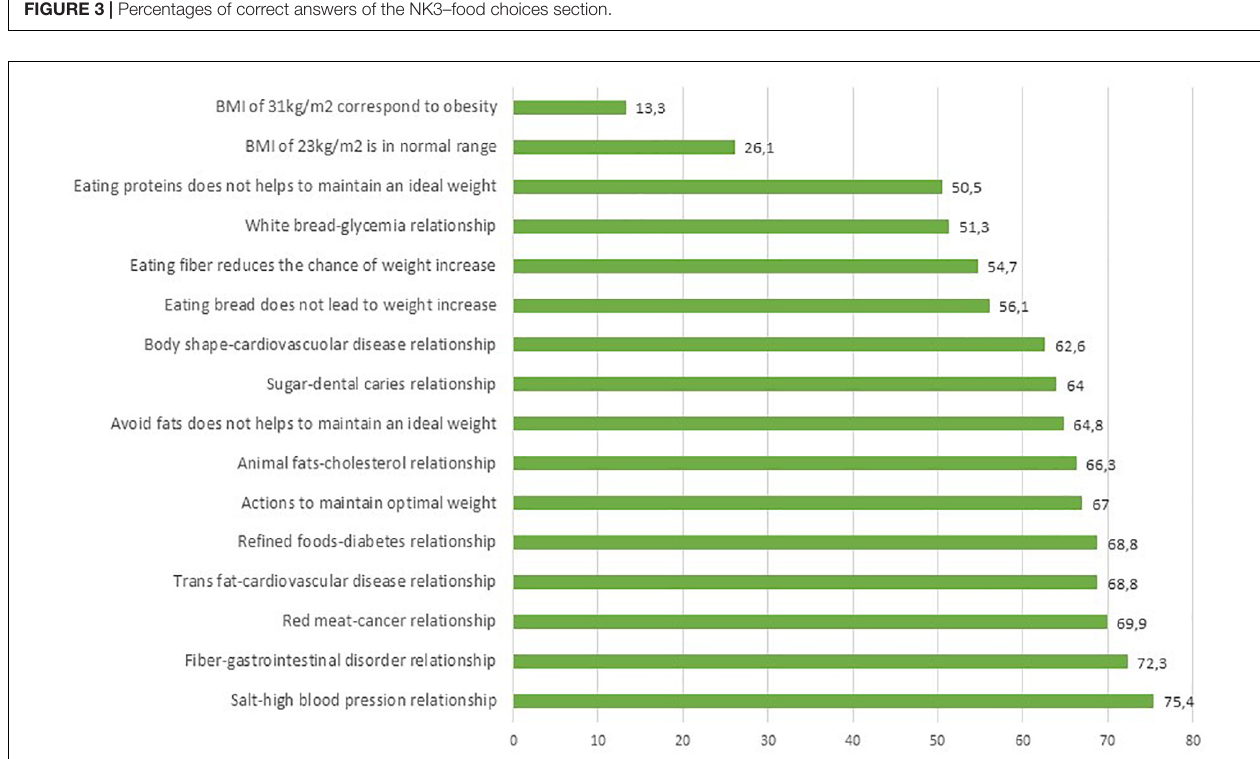
FIGURE 3 | Percentages of correct answers of the NK3–food choices section.